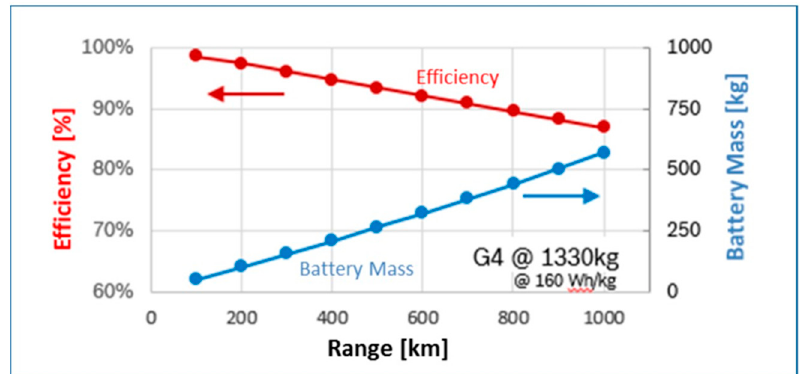
Figure 2. Adding battery weight decreases efficiency, which was revealed by an internal analysis based on G4 Vehicles (Golf class). Reproduced from [10].